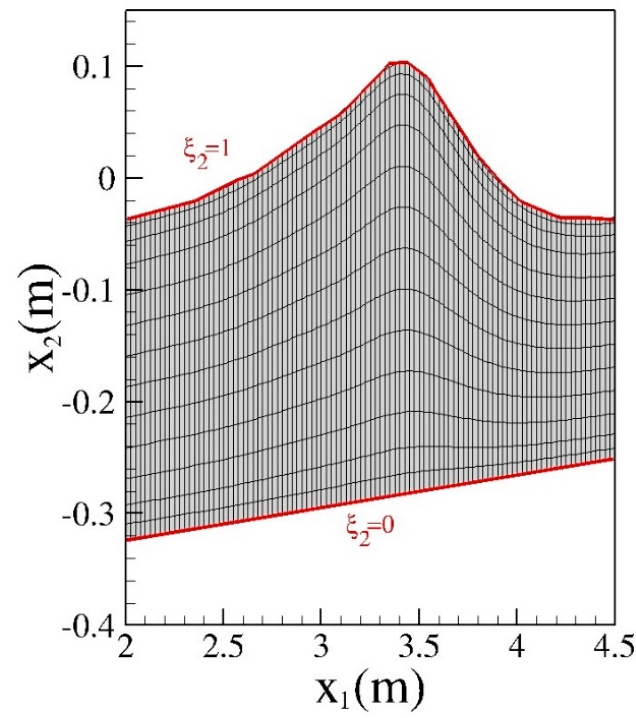
Figure 1. A particular representation of the mesh in which ξ 2 = 0 represent the bottom and ξ 2 = 1 represent the free surface.